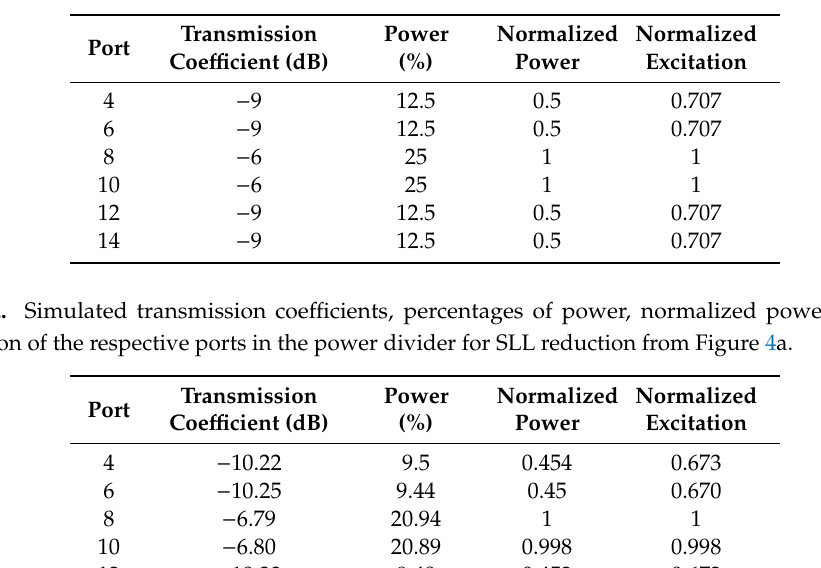
of the respective ports in the power divider for SLL reduction from Figure 4a.